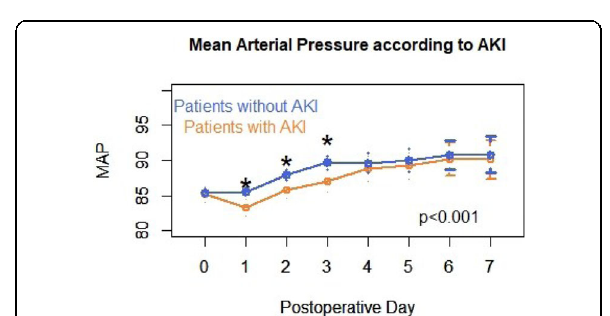
Fig. 2 (abstract 001755). See text for